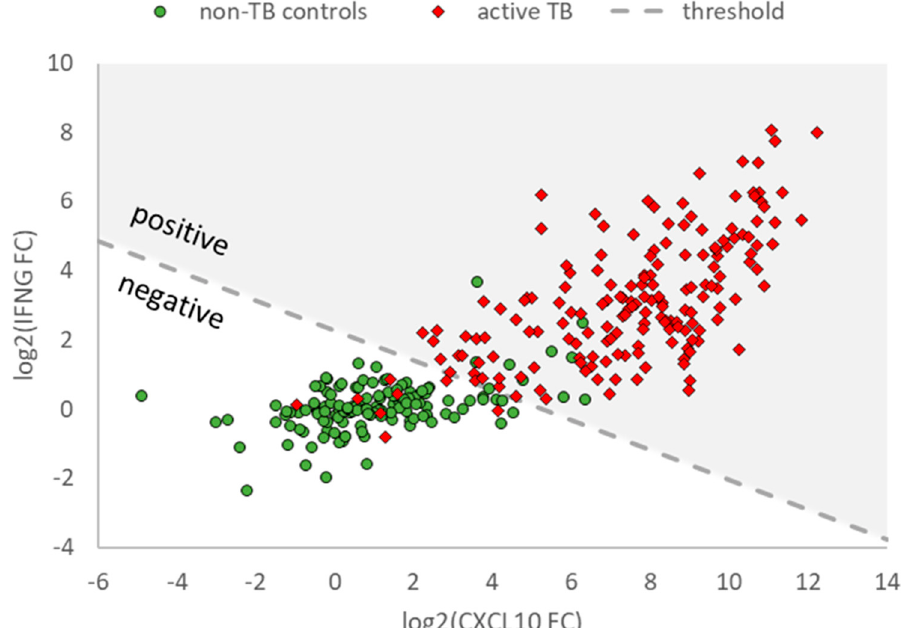
Figure 3. IFNG and CXCL10 mRNA expression levels in samples from patients with active TB and uninfected study participants obtained with T-Track ® TB. Scatter plot showing valid log2-transformed fold change (FC) values of IFNG and CXCL10 mRNA levels in samples from patients with active TB (red diamonds) and uninfected study participants (green circles). Only samples with valid results for both markers are shown ( n = 176 active TB, n = 135 non-TB controls). The dashed line (classification threshold) classifies the samples into “positive” (upper right) and “negative” (lower left).